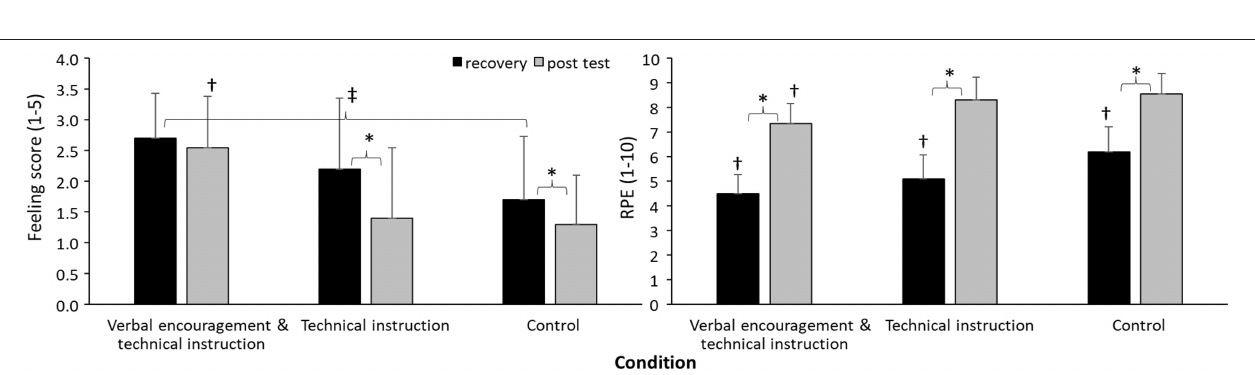
FIGURE 1 | Mean [standard deviation ( SD )] for number of passes in the first and second set of a small-sided passing game in the three conditions. *indicates a significant difference from 1st to 2nd set at a p < 0.05 level. † indicates a significant difference with all other conditions for this set at a p < 0.05 level.